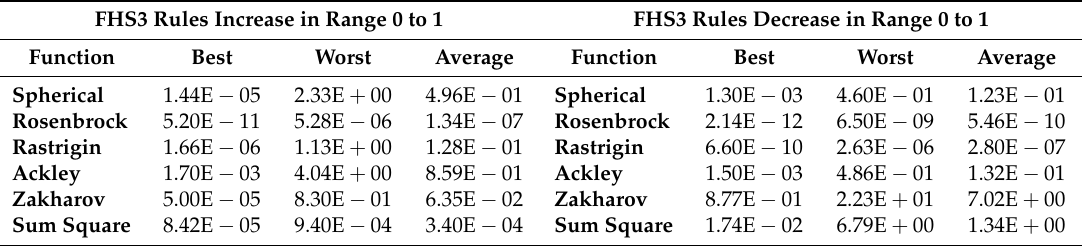
Table 9. Comparison of results obtained with FHS 3 using fuzzy logic rules for increasing and decreasing using the range 0 to 1 for the two outputs.